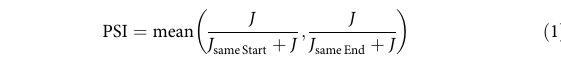
Fig. 8 Model for how the 5 ′ SS – BS distance leads to the dependence of spliceosome activation on Smu1/RED. a Distance between 5 ′ SS and BS in the human B complex 29 . Left, overview of the complete human B complex. Right, expanded view of the upper region where intron nucleotides between the 5 ′ SS and BS should be located in short introns. The intron (red solid line) forms extended helices with the U6 ACAGAG box and adjacent U6 nucleotides (yellow) at the 5 ′ SS and the U2 snRNA (green) at the BS. The two helices are separated by 15 nm (ca 21 nt, red dashed line) in the human B complex. This would accommodate an estimated minimum of 52 nt between the 5 ′ SS and the BS, without altering the structure of the spliceosome. b Model of the role of Smu1 and RED in the B complex. Upper left, Smu1/RED supports/stabilises the formation of the Brr2-U2 bridge, which is likely important for spliceosome activation. In the absence of Smu1/RED, this bridge can still be formed, albeit at a slower rate, as long as the distance between the 5 ′ SS and BS is suf fi ciently long to allow movement of the U2 domain towards Brr2, resulting in a direct Brr2-U2 interaction. Lower left, when the distance between the 5 ′ SS and the BS is short, the U2 snRNP may be repositioned and/or its ability to move towards Brr2 may be inhibited due to the structural constraint of the intron. Therefore, no direct contact between U2 and Brr2 can be established, and Smu1 and RED become essential for activation. Lower right, splitting the MINX80 pre-mRNA into two pieces may relieve this constraint, allowing the B-to-B act transition even in the absence of Smu1 and RED. Panel ( a ) was reprinted from Bertram, K. et al. Cryo-EM structure of a pre-catalytic human spliceosome primed for activation. Cell 170 , 701 – 713 (2017), with